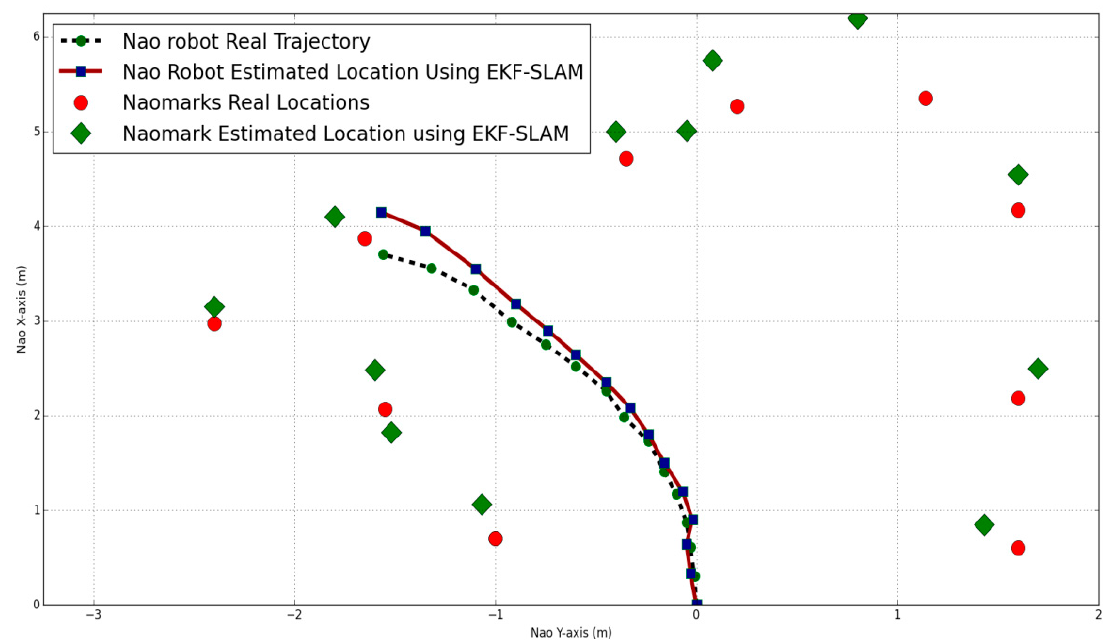
Figure 16. NAO location and NAO markers positions with real-time implementation of EKF SLAM.